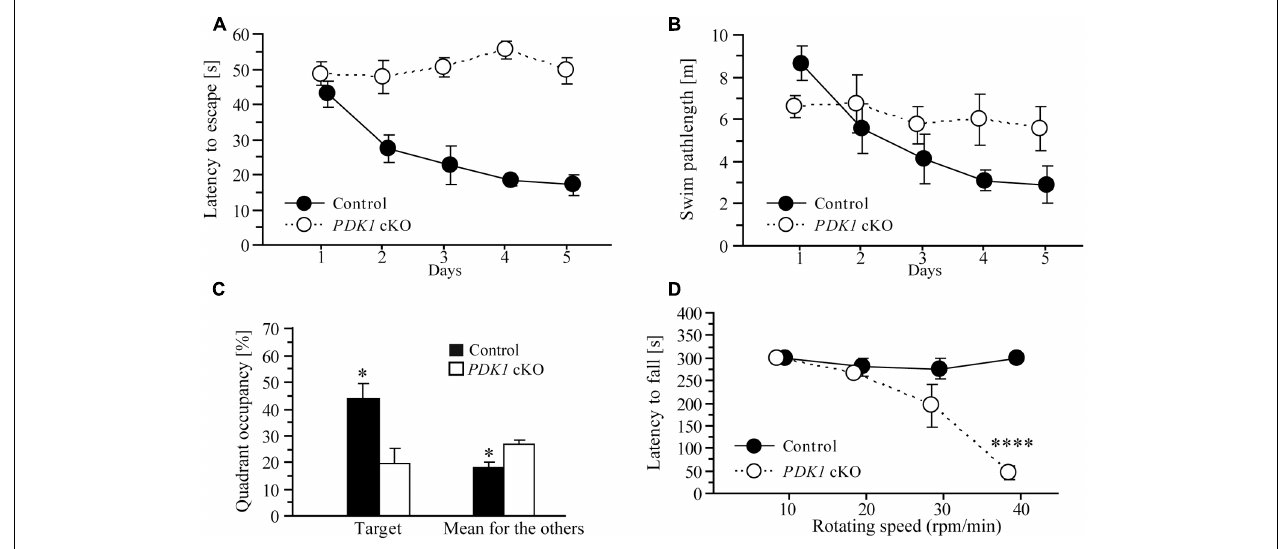
FIGURE 5 | Learning deficit in PDK1 cKO mice. (A) Escape latency for control and PDK1 cKO mice which were trained with a hidden platform task for 5 consecutive days. There was significant difference on the latency to escape between the two genotype groups ( n = 6/group). PDK1 cKO mice showed no improvement on their performance during the 5-day training. (B) The length of swim-path. There was significant difference between control and PDK1 cKO mice across the training period. (C) Quadrant occupancy in a probe test conducted 24 h after the last training trial. There was significant difference on the time spent in the target quadrant between control and PDK1 cKO mice ( ∗ p < 0.05). There was also significant difference in the average time spent in the remaining three quadrants (adjacent left, adjacent right, and opposite) between control and PDK1 cKO animals ( ∗ p < 0.05). (D) Latency to fall from a rotarod. Four different rotating speeds including 10, 20, 30, and 40 rpm/min were used. There was no significant difference on the latency to fall between control ( n = 10) and PDK1 cKO mice ( n = 6) at lower speeds ( p s > 0.1). There was significant difference between control and PDK1 cKO mice at the highest speed ( ∗∗∗∗ p <